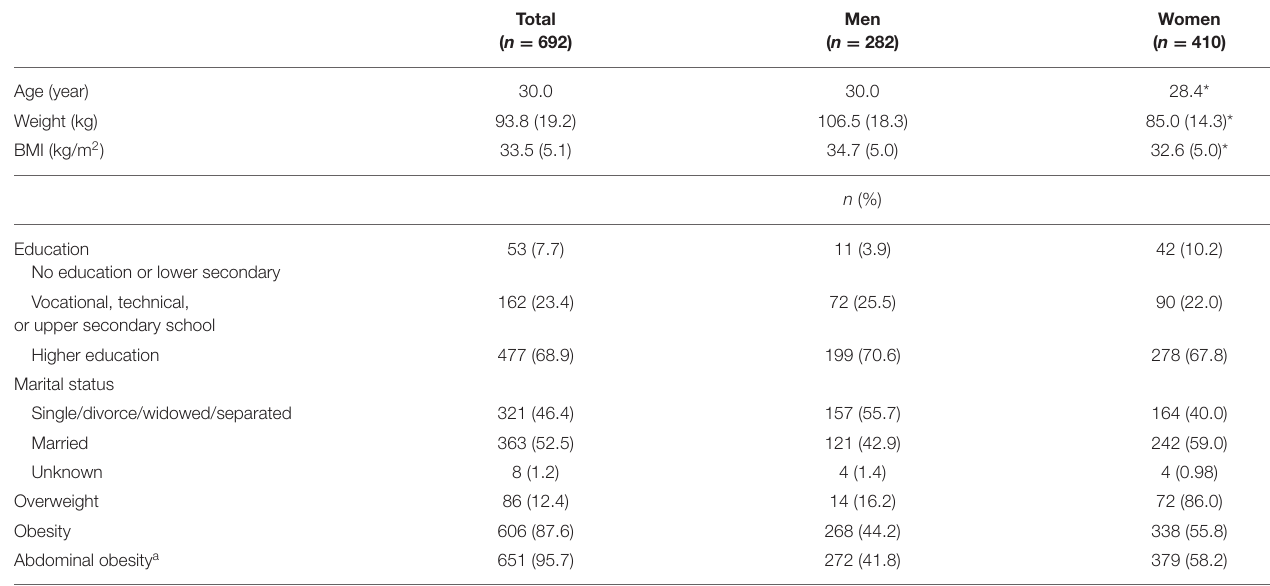
TABLE 3 | Baseline characteristics of participants (2015–2020).